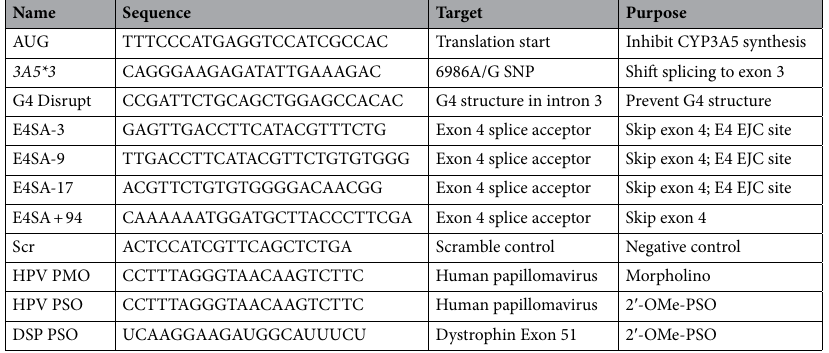
Table 1. Antisense oligonucleotide sequences.